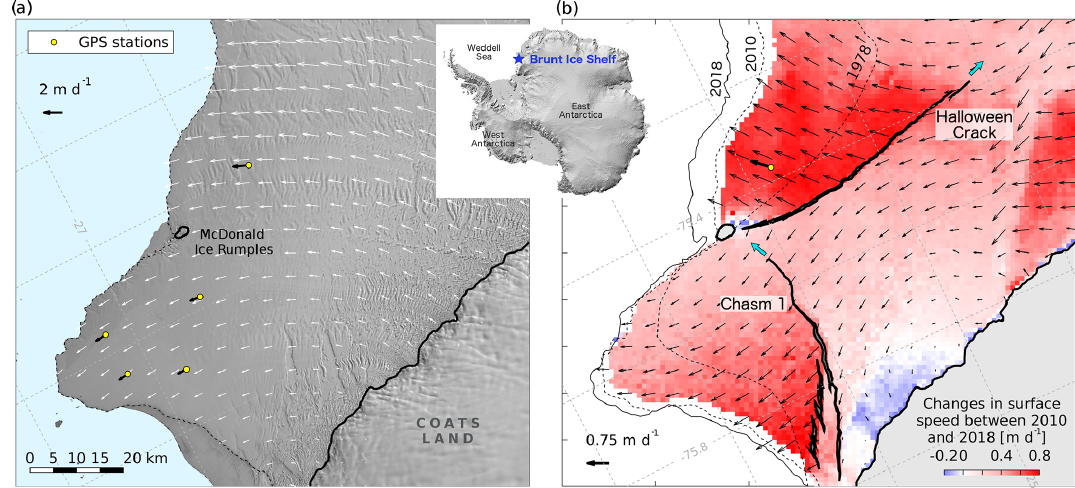
Figure 1. Map of the Brunt Ice Shelf with inset showing its location in relation to the Antarctic continent (Howat et al., 2019). Panel (a) shows the ice shelf in 2010, prior to rifting. The grounding lines (solid black lines; Bindschadler et al., 2011), open ocean shaded in blue, and surface velocities from the MEaSUREes 2010–2011 annual Antarctic velocity map (white arrows; Mouginot et al., 2017) are overlain on a Landsat 7 panchromatic image collected on 4 January 2010. All velocity maps in this study have been cross-calibrated to data from a network of up to 15 in situ GPS stations. The configuration of the network in 2010 is shown by the yellow dots, with corresponding velocity arrows in black. Panel (b) shows the extent of two active rifts – “Chasm 1” and “Halloween Crack” – in October 2018, with cyan arrows indicating their direction of propagation. Black arrows represent velocity anomalies between 2010, prior to rift initiation, and February 2018 (Sentinel-1 data), showing a dramatic increase in flow as a result of ice shelf rifting. Blue to red colours illustrate the corresponding change in surface speed. Ice front locations in 1978, 2010 and 2018 are shown for